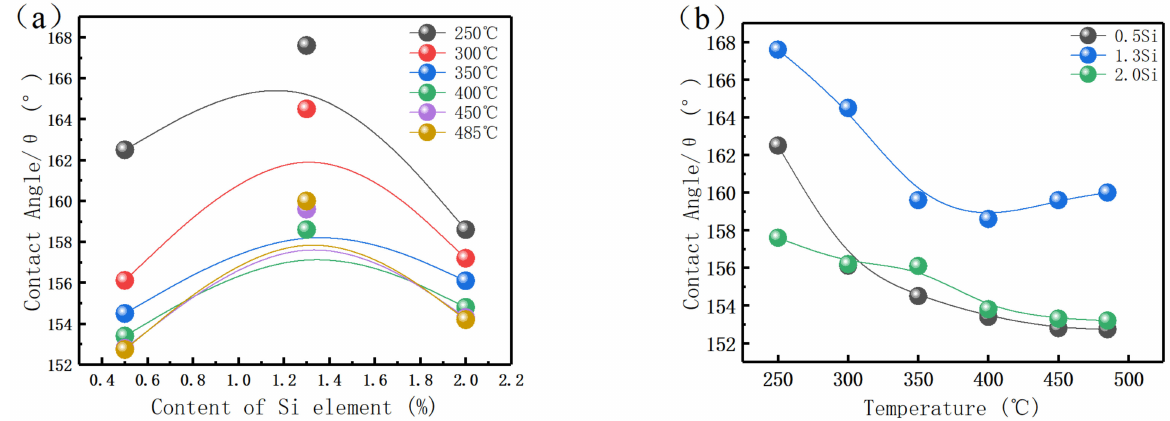
Figure 8. ( a ) Si effect on contact angle. ( b ) Temperature effect on contact angle. The relationship between contact angle and surface tension is shown in Figure 9. When the LBE droplet contacts the surface of steels, surface tension will be generated between the three interfaces, which are solid–liquid interfacial tension, gas–liquid interface tension, → → → γ sv , γ sl , γ vl . and solid–gas interface tension